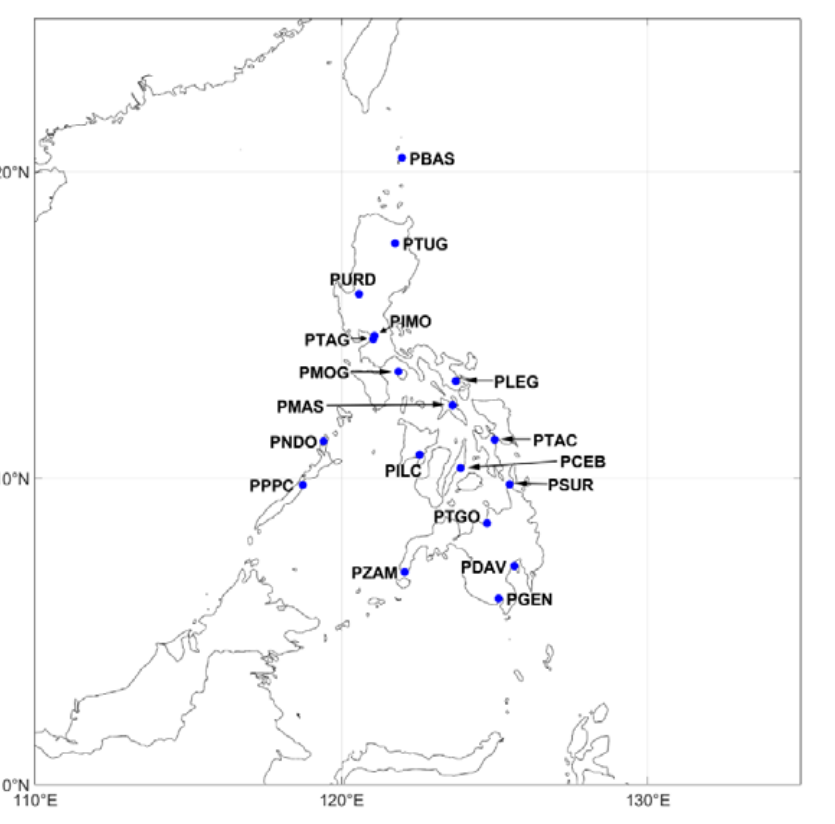
Figure 1. Distribution of GNSS receiver stations in the Philippines used. All these stations are from PAGeNet except for PIMO, which is part of IGS.